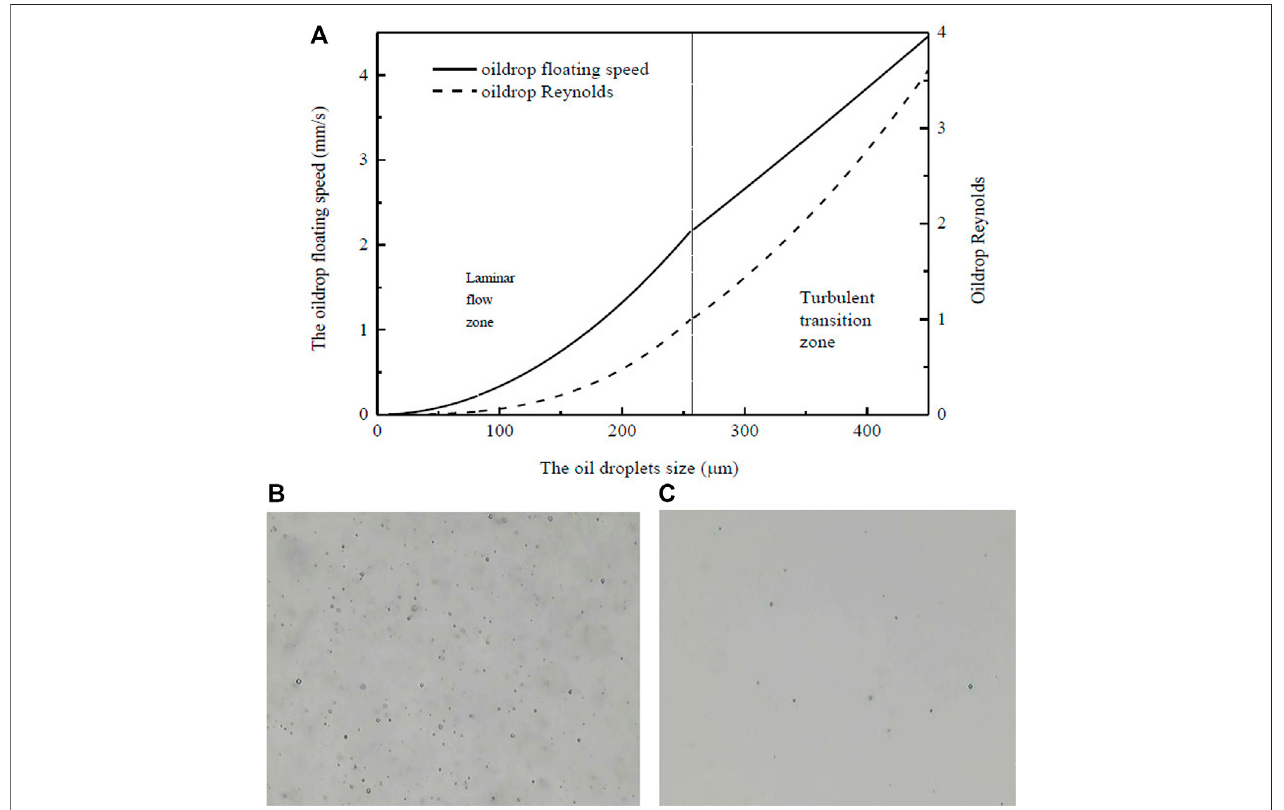
FIGURE 3 | Floating speed (A) and distribution of oil droplets in in fl uent (B) and ef fl uent (C) of oil fi eld-produced water.